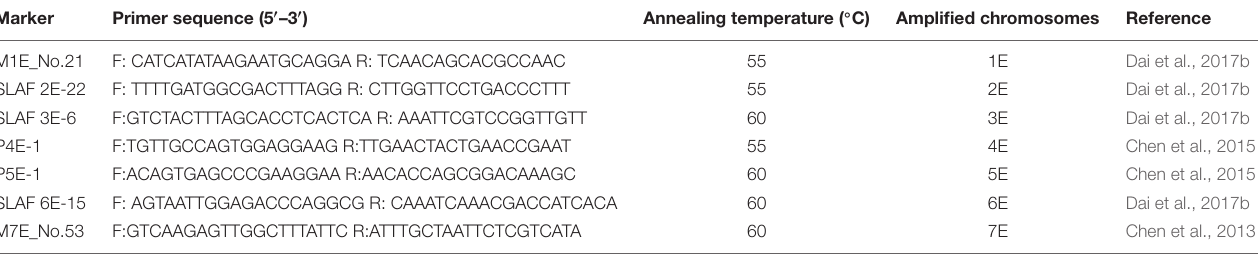
TABLE 2 | Sequences of E-genome chromosomes specific markers.